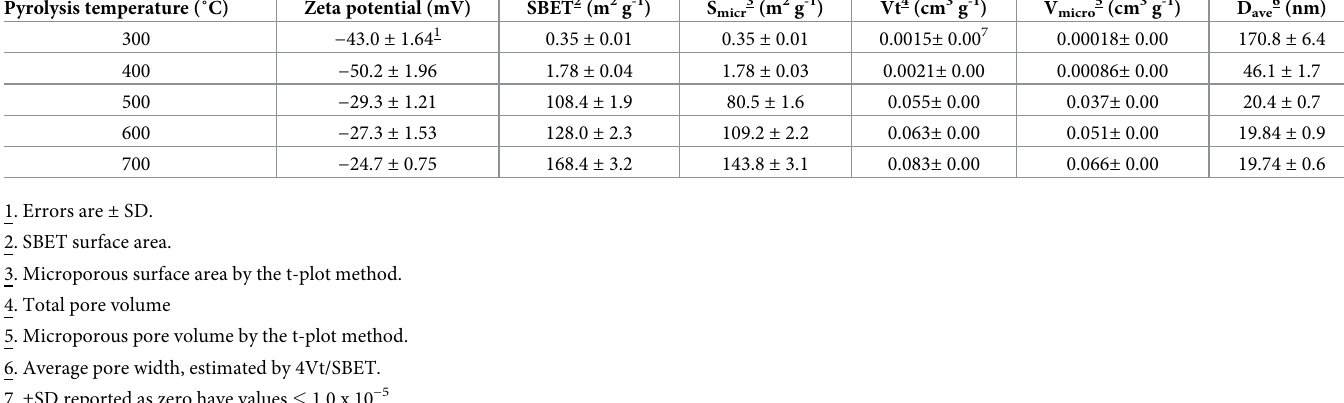
Table 2. Zeta potential, surface area and pore properties of Olive Mill Solid Waste-derived Biochars (OMSW-BCs). Pyrolysis temperature